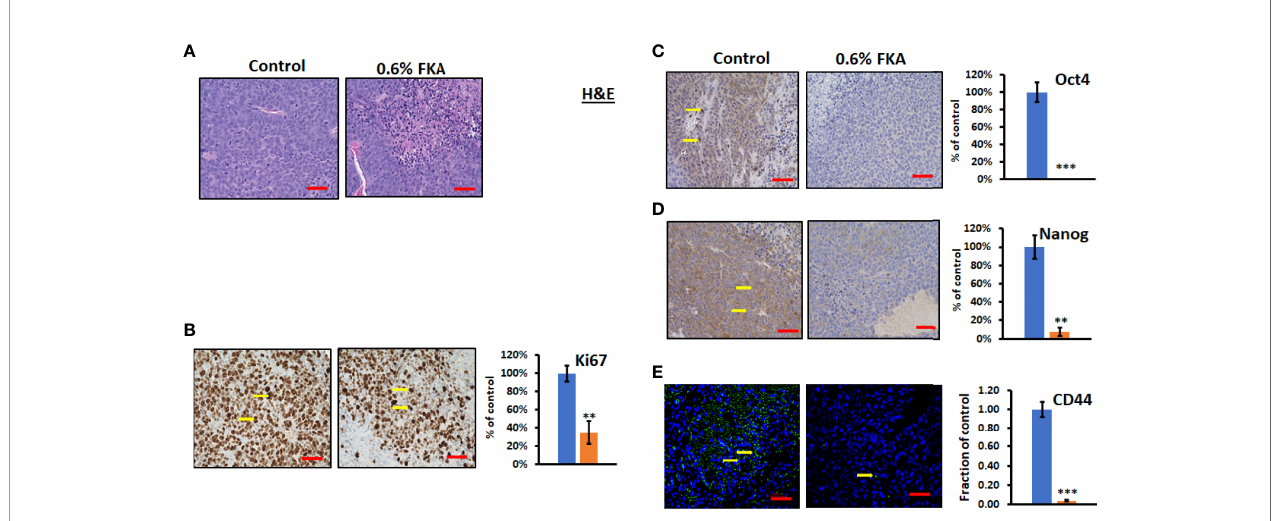
FIGURE 4 | FKA inhibits the expression of CSC markers in CSC xenograft tumors. (A) H&E-stained tumor tissues. (B, C) IHC- or immuno fl uorescence-stained tissue sections by anti-Ki67, -Oct4, -Nanog, and -CD44 antibodies, respectively, were photographed at ×40 (scale bar 50 µm) magni fi cations, and the quanti fi cation of the positive staining cells (yellow arrows) of FKA-treated tumors relative to control-treated tumors was shown **P<0.01 and ***P<0.001.